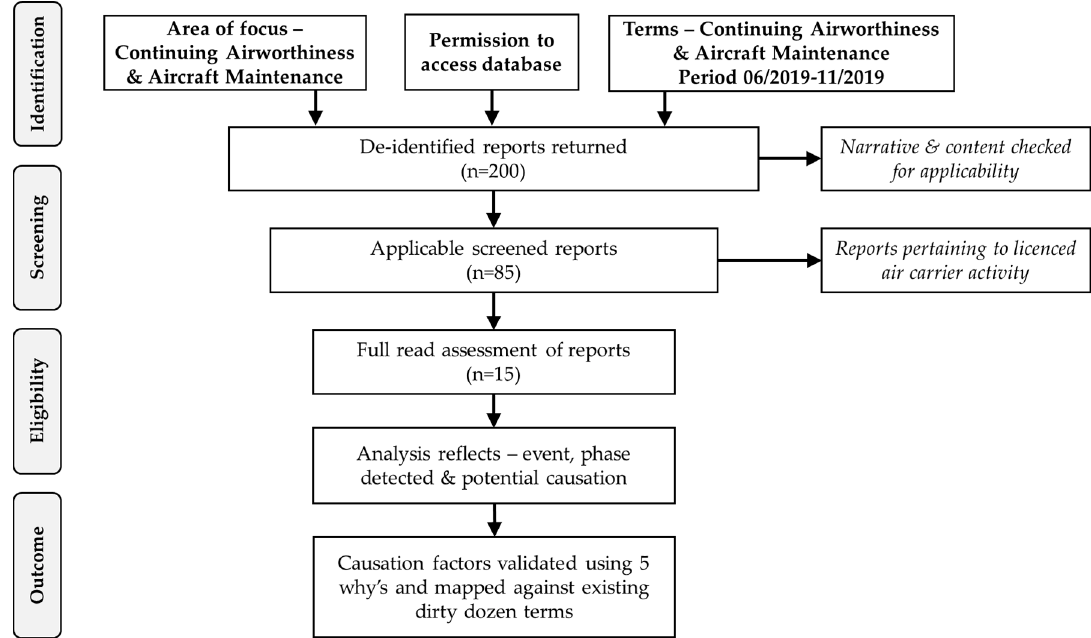
Figure 2. Overview of the analysis framework applied. The systematic review phases (identification-screening-eligibility- outcome) follow the methodology of Liberati et al. [26].